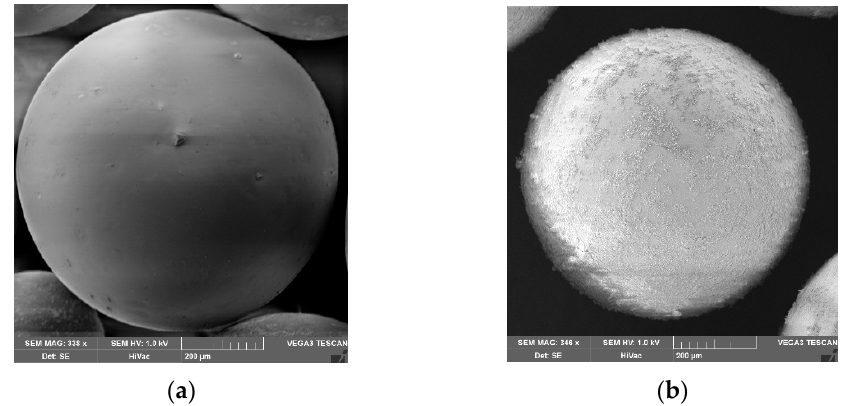
Figure 2. Scanning electron microscopic study of the surface morphology of the “raw” ( a ) and impregnated ( b ) Amberlite XAD-4 resin .